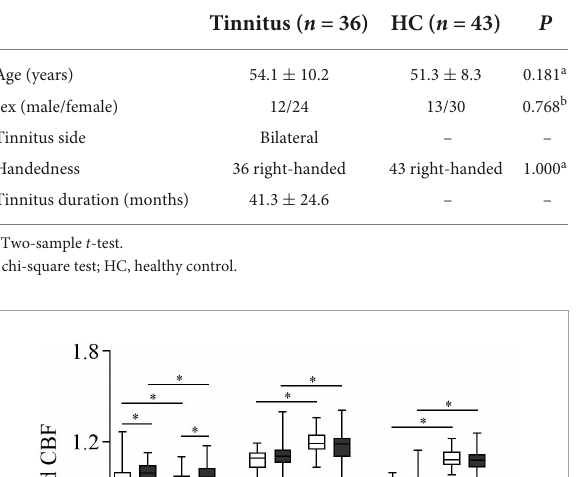
TABLE 1 Sample characteristics of patients with tinnitus and HCs.